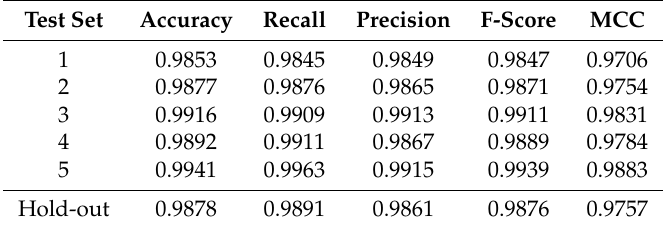
Table 5. Performances of deep neural network/protein–protein interaction (DNN-PPI) framework on the benchmark